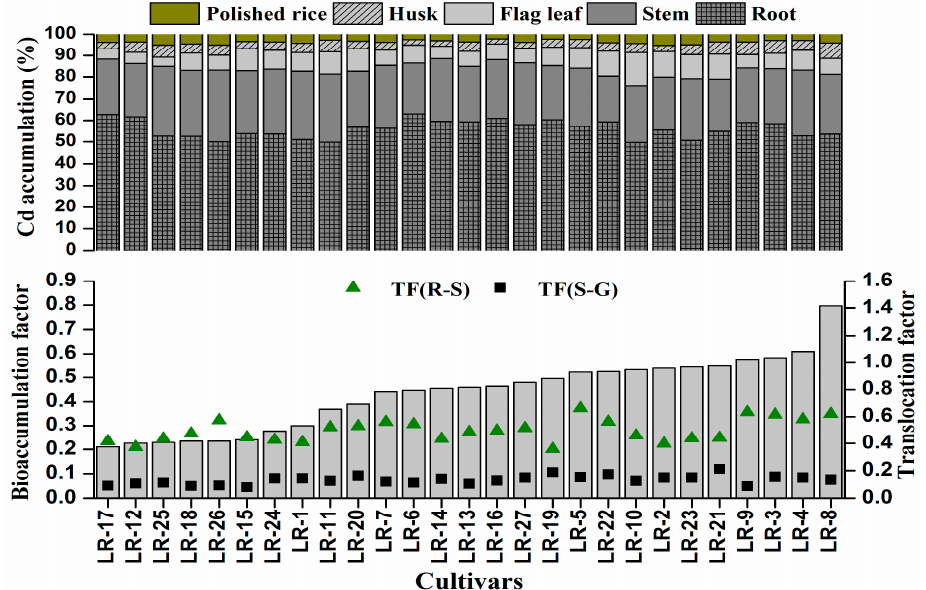
Figure 4. Cadmium accumulation in different parts of plant, bioaccumulation factor in polished rice grain and translocation factor of 27 late rice genotypes grown on contaminated soil. Where TF(R-S) and TF (S-G) represents root to shoot and shoot to grain translocation, respectively.